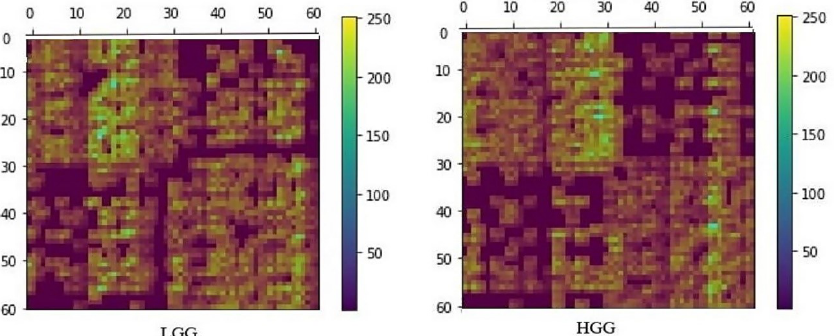
Figure 5. A typical heatmap of an LGG (left) and an HGG (right) patient is shown. This heatmap was obtained from the trained DNN where the connectivity matrix was considered as a matrix. To illustrate, the heatmap was superimposed on a FA connectivity matrix image from a typical LGG and HGG patient. The 0-61 axis values refer to 62 ROIs from DesikanDKT Atlas (refer to the sup- plementary table for more details of the ROIs). The color scale depicts the heatmap values.